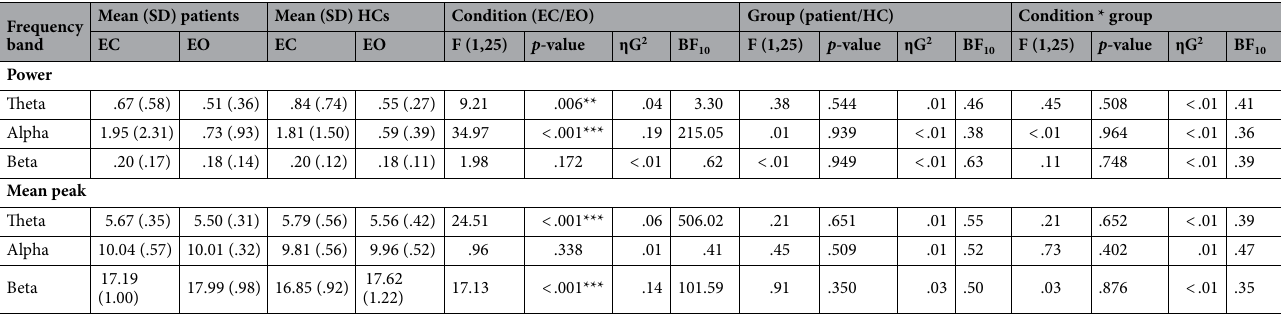
Table 1. Comparison of global power and mean peak frequency outcomes between patients ( n = 13) and healthy controls (HC; n = 14) during eyes closed (EC) and eyes open (EO) resting states. The displayed means are based on the untransformed variables. For theta and alpha power, the analysis of variance was conducted using square-root transformed variables. SD = standard deviation. η G2 = generalised eta squared. BF 10 = Bayes factor, evidence towards alternative hypothesis. * p < .05; ** p < .01; *** p < .001.